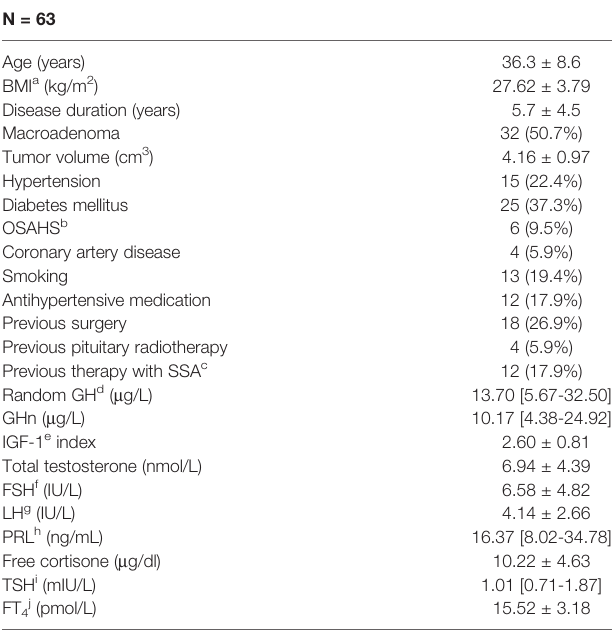
TABLE 1 | Clinical baseline characteristics of 63 male patients with acromegaly.